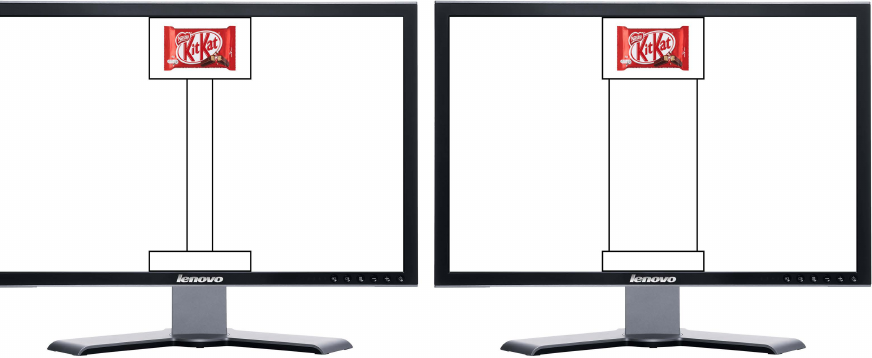
Figure 1. Examples of visual stimuli and paths. Shown brands for demonstrative purpose